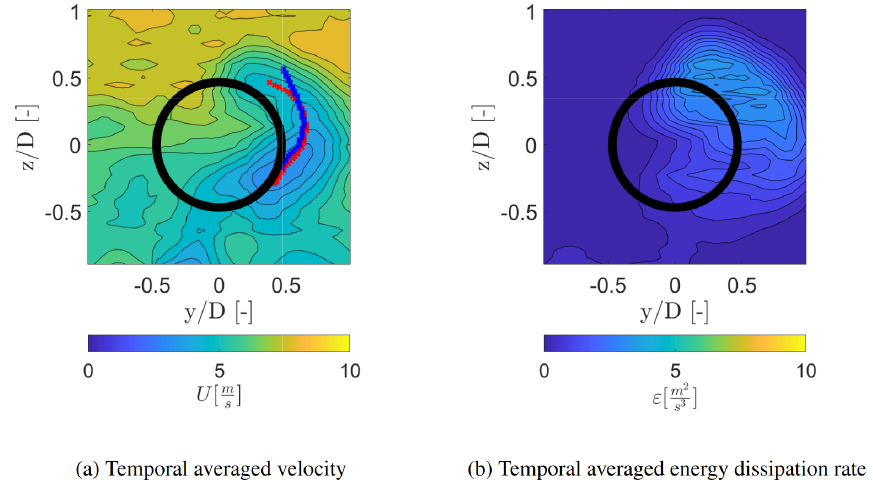
Figure 16. Temporal averaged velocity (a) and energy dissipation rate (b) obtained from the hot-wire measurements conducted in the WindScanner campaign. The position of the minimum velocity determined at each z position, which indicates the curvature of the wake centre, obtained from the WindScanner (blue crosses) and the hot wire (red crosses) is